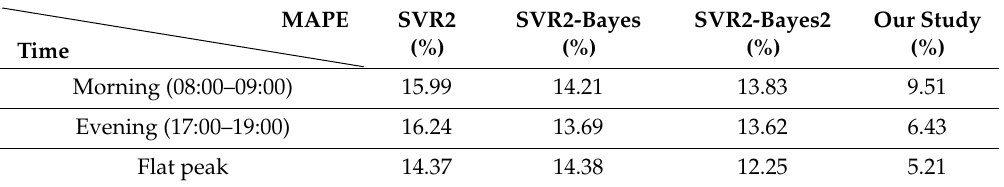
Table 4. MAPE values for di ff erent methods in di ff erent periods.